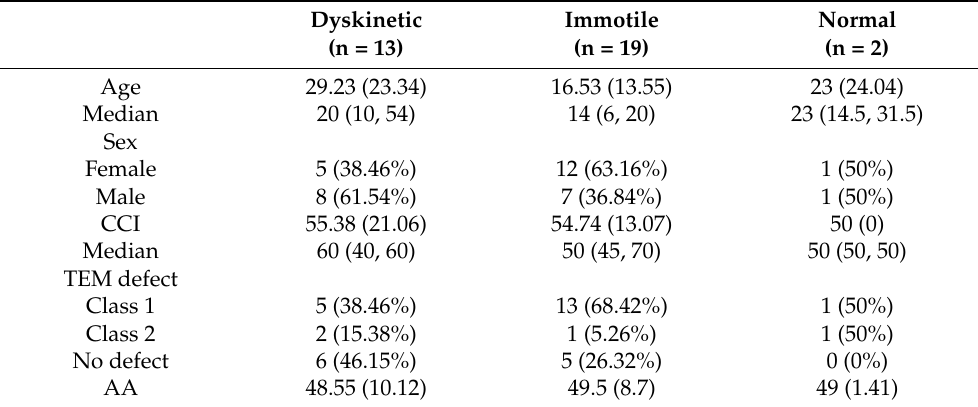
Table 5. Distribution of HSVA with demographic characteristics, ICC, ultrastructural defects and axonemal